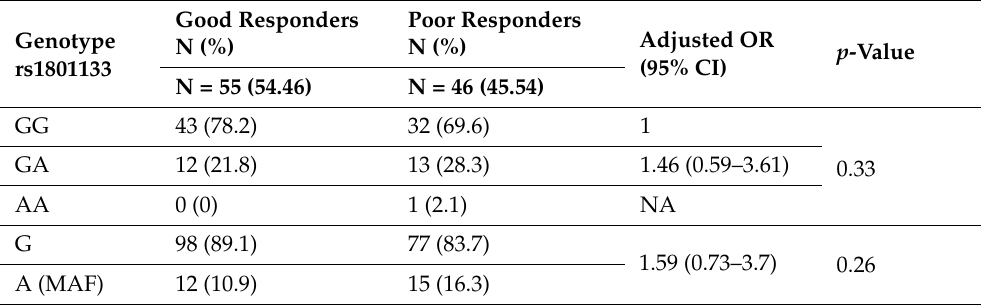
Table 4. Genotype distributions of MTHFR and allele frequencies among good and poor Table 3. Genotype distributions of MTHFR and allele frequencies among all participants. ASM